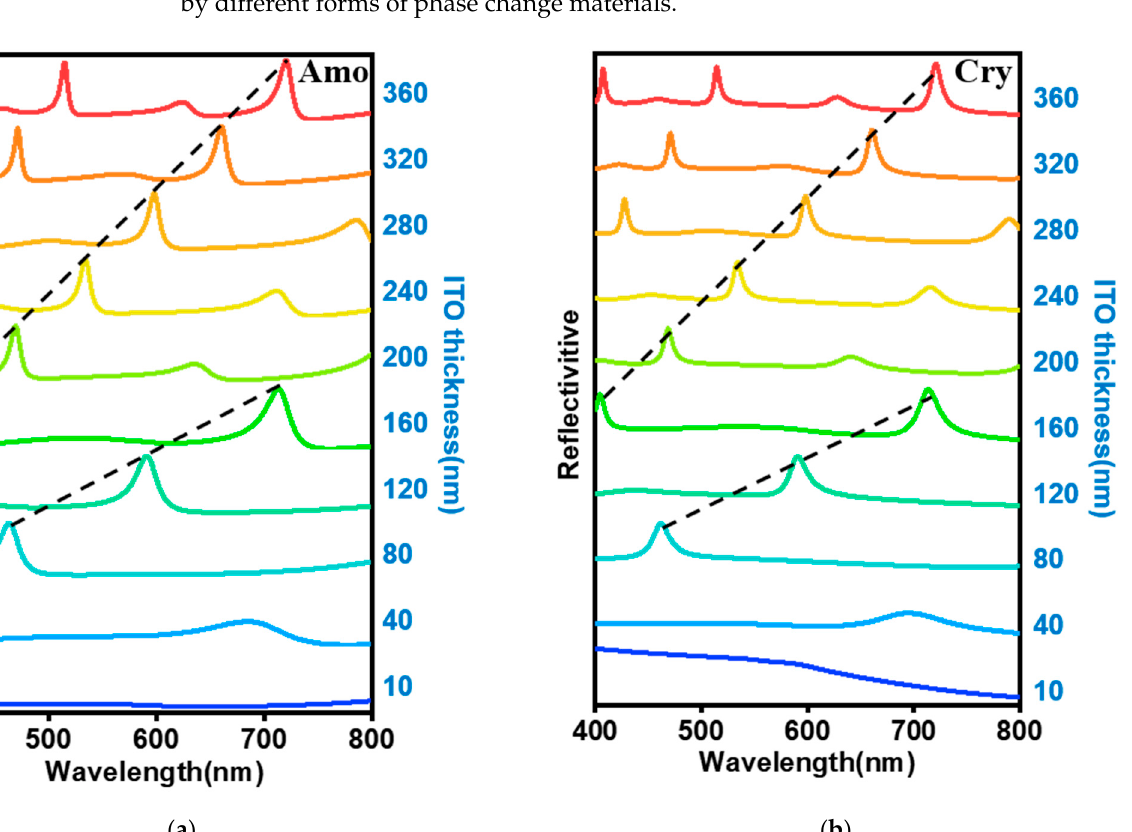
Figure 8. The amorphous ( a ) and crystalline ( b ) phase change materials simulate the reflection spec- tra of the multi-media mechanism. The thickness of ITO increases from 10 nm to 360 nm. of the multi-media mechanism. The thickness of ITO increases from 10 nm to 360